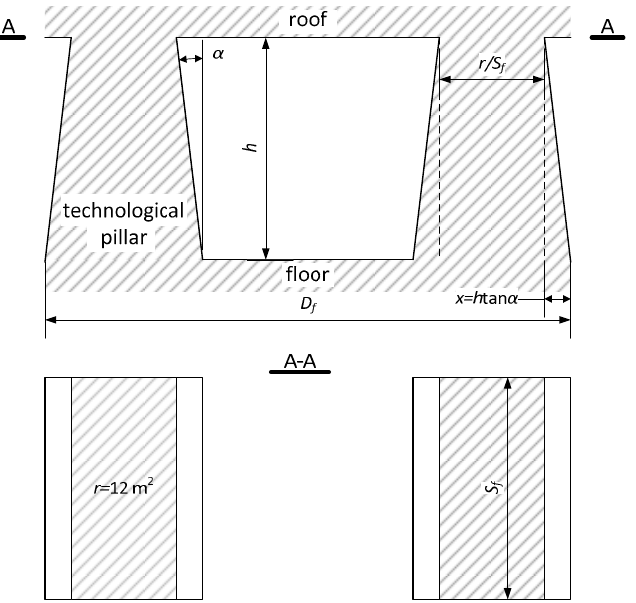
Figure 6. The dimensions of the technological pillar with the undercut marked; there will be two remaining pillars with the cross-section area r = 12 m 2 under the roof [24].